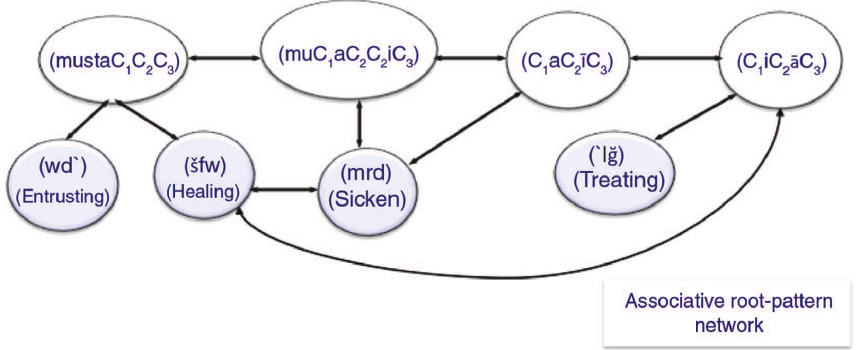
Figure 1: An Example of Associative Root-Pattern (Morpho-Phonetic) Network Containing Bi-directional Associative Relationship between Roots and